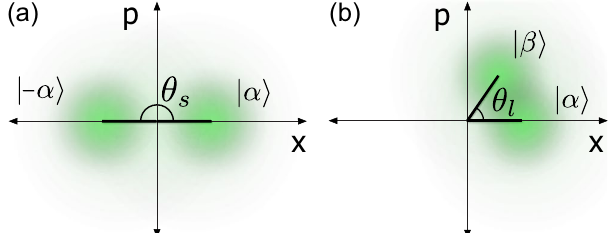
Figure 2. Illustrative phase space representation of the back-reflected states. Eve attempts to discern ϕ B = 0 or π /2 by performing optimal detection on the back-reflected weak coherent states | α 〉 and | β 〉 that have a non- zero overlap. ( a ) The complex amplitude β α α = = − θ e i s , as a result of the double pass at the attack wavelength of λ s . ( b ) β α = θ e i l , as a result of the single pass at λ l through Bob’s